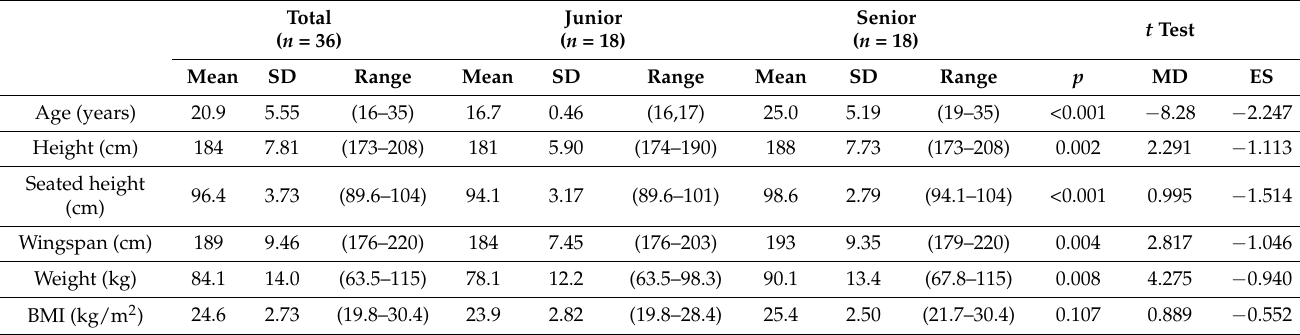
Table 1. Anthropometric